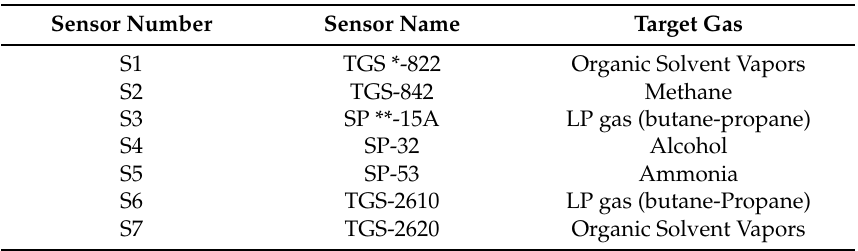
Figure 3. Response patterns of sensors to volatile oils, ( a ) and ( b ) represent, respectively, resistance and conductance evolution through time in the different stages of a single EN essential oil sample measurement. Table 1. Sensor array used in the electronic nose system.